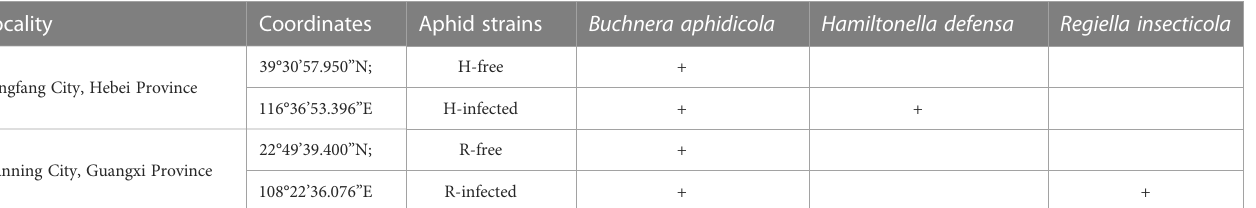
TABLE 1 Symbionts infection in different aphid